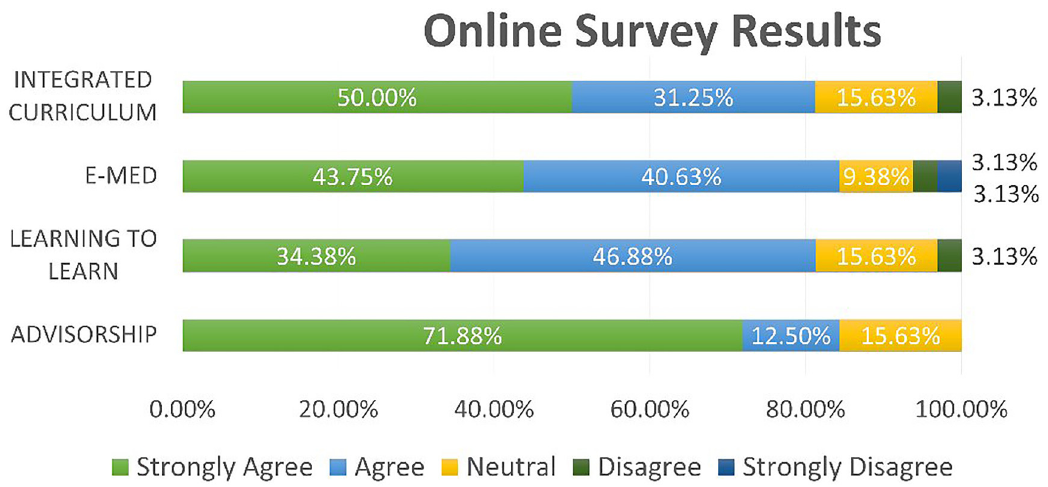
Figure1A: Stackedbargraphshowingtheresultsof Likert-scalequestionsofanonlinesurveyabout thestudentsatisfactionof keyconcepts.